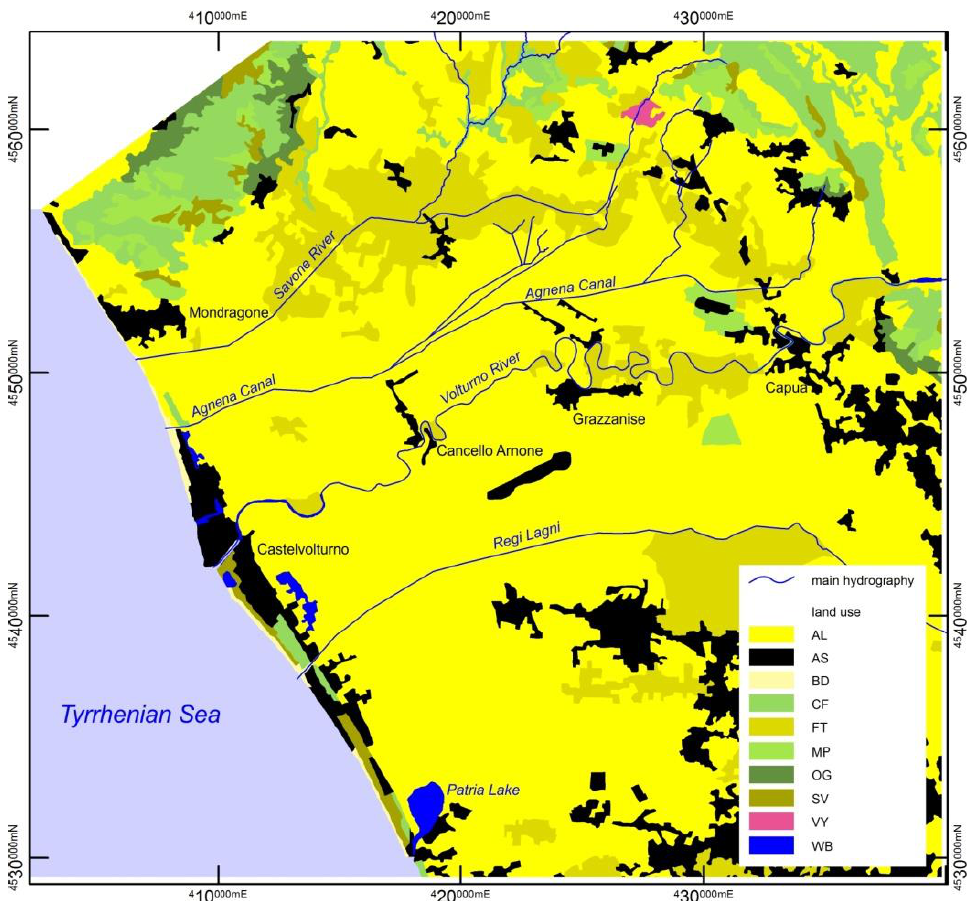
Figure 3. Land use map. Key: AL Arable Land; AS Artificial Surfaces; BD Beaches, Dunes; CF Coniferous Forest; FT Fruit Trees; MP Meadow and Pasture; OG Olive Grove; SV Sclerophyllous Vegetation; VY Vineyards; WB Water Bodies.